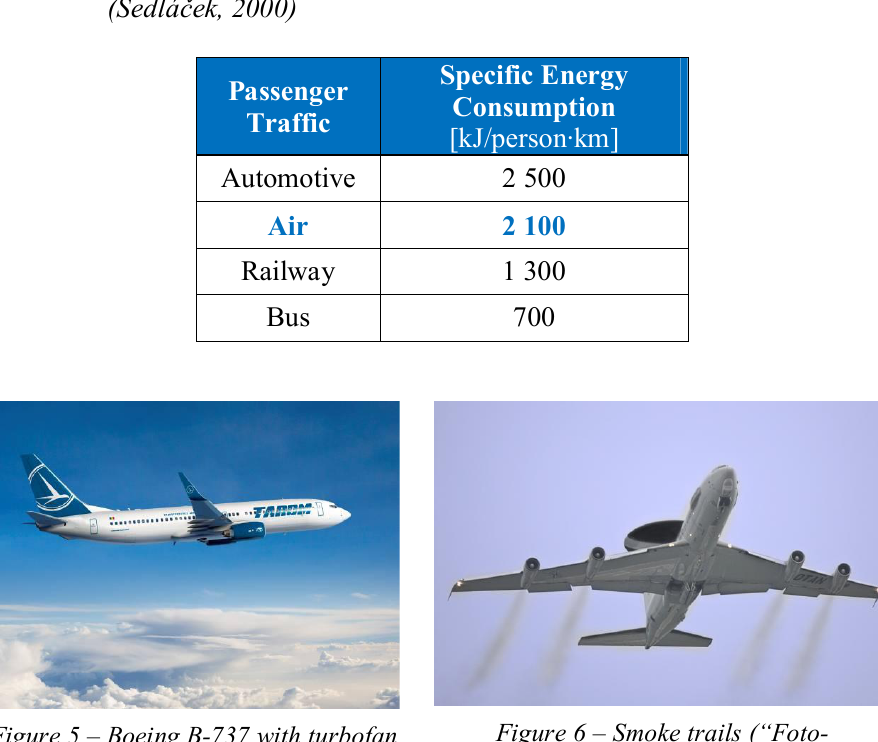
Figure 5 – Boeing B-737 with turbofan engines (Tarom)